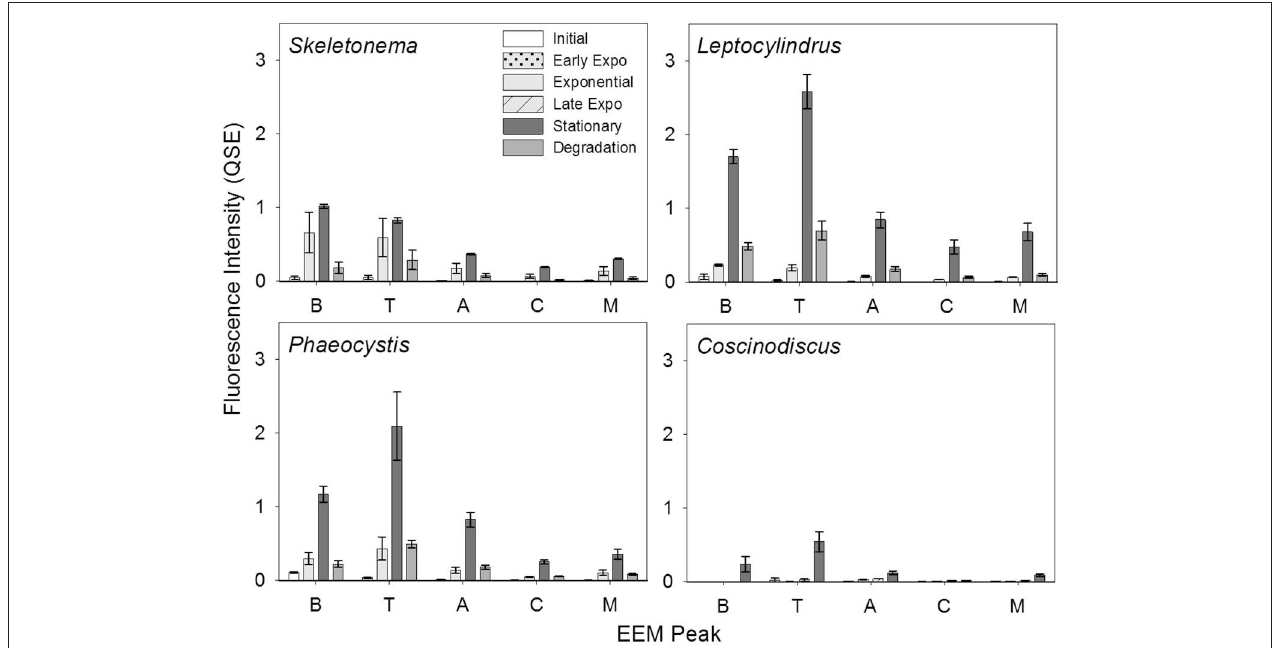
FIGURE 2 | BEPOM fluorescence intensity of Coble EEM peaks over growth and degradation for genera Skeletonema ( n = 3), Leptocylindrus ( n = 2–4), Phaeocystis ( n = 3), and Coscinodiscus ( n = 3–4). Note the different growth stages for Coscinodiscus sp. All data are presented as mean ± standard error.